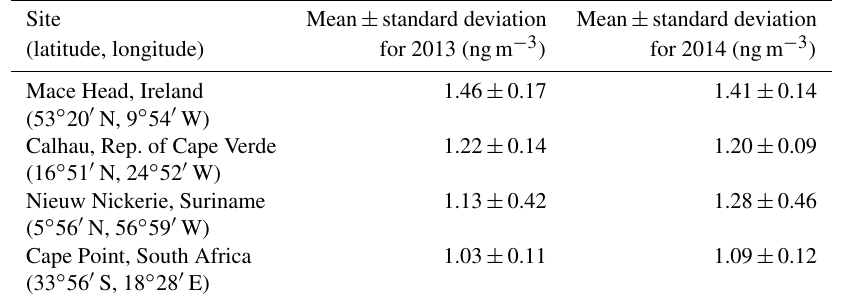
Figure 3. Seasonal cycle of TGM at CVO. The bars represent the standard deviation of the monthly averages. Table 1. Average TGM concentrations and standard deviation statistics from comparable sites in 2013 and 2014. Data from Sprovieri et al.